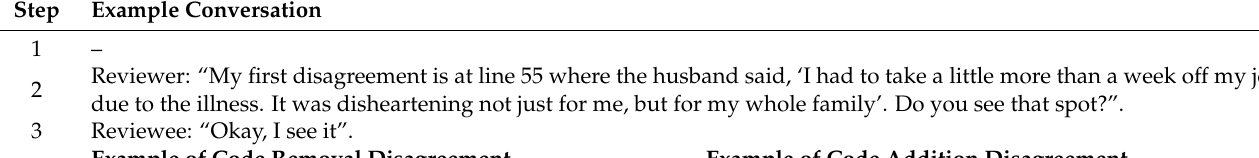
Table 4. Meeting and consolidating partner reviews—example